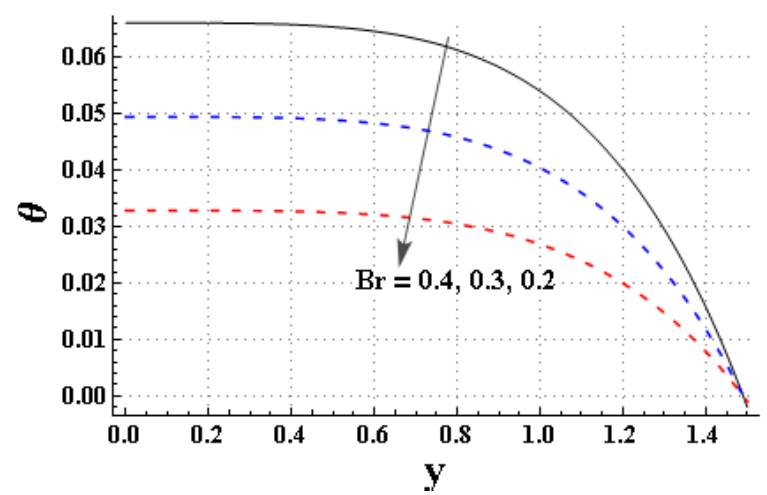
Figure 8. Effect of the Brinkman number, Br , on temperature, θ .